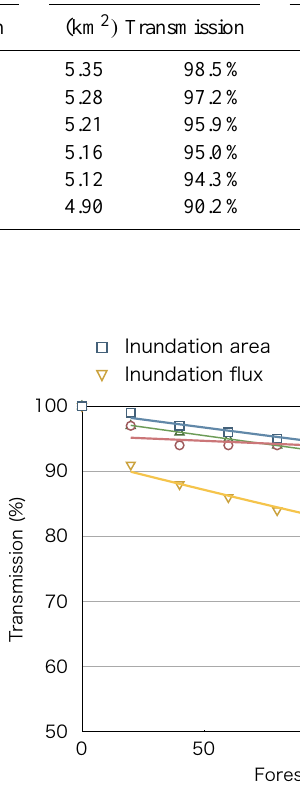
Fig. 11. The transmission of tsunami inundation with the forest width. Harada and Imamura (2005) indicated 50% transmission of the inundation depth with 200 m of forest width. The forest had high tree density of 30 trees/100 m 2 with 0.15 m of DBH, and they measured at just behind the center of post edge of forest with 200 m forest width. The transmission result of this study is 93%, with relatively large improvement from Harada and Imamura(2005). Although the measurement approach is different, the forest stand volume can also take a valuable contribution to the hydraulic drag. Hence, for the accurate estimation of tsunami inundation, forest expansion and stand volume are essential information.